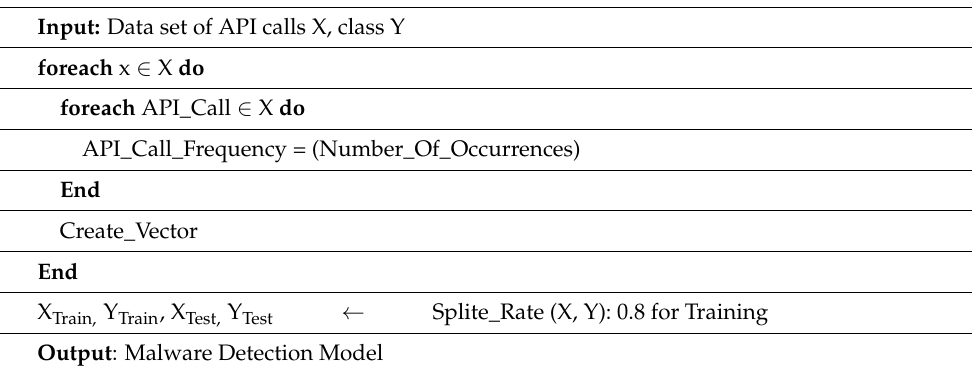
Algorithm 2: Features Extraction and